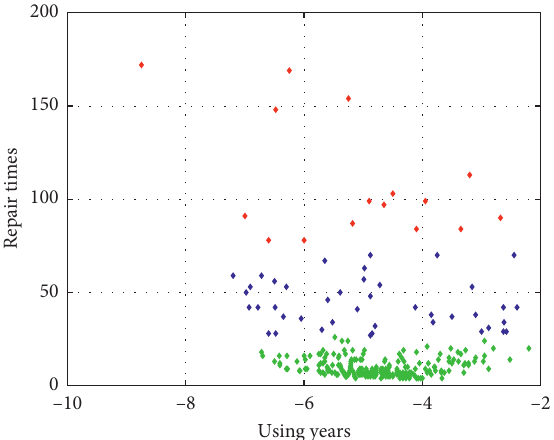
Figure 5: Classification of the datasets.